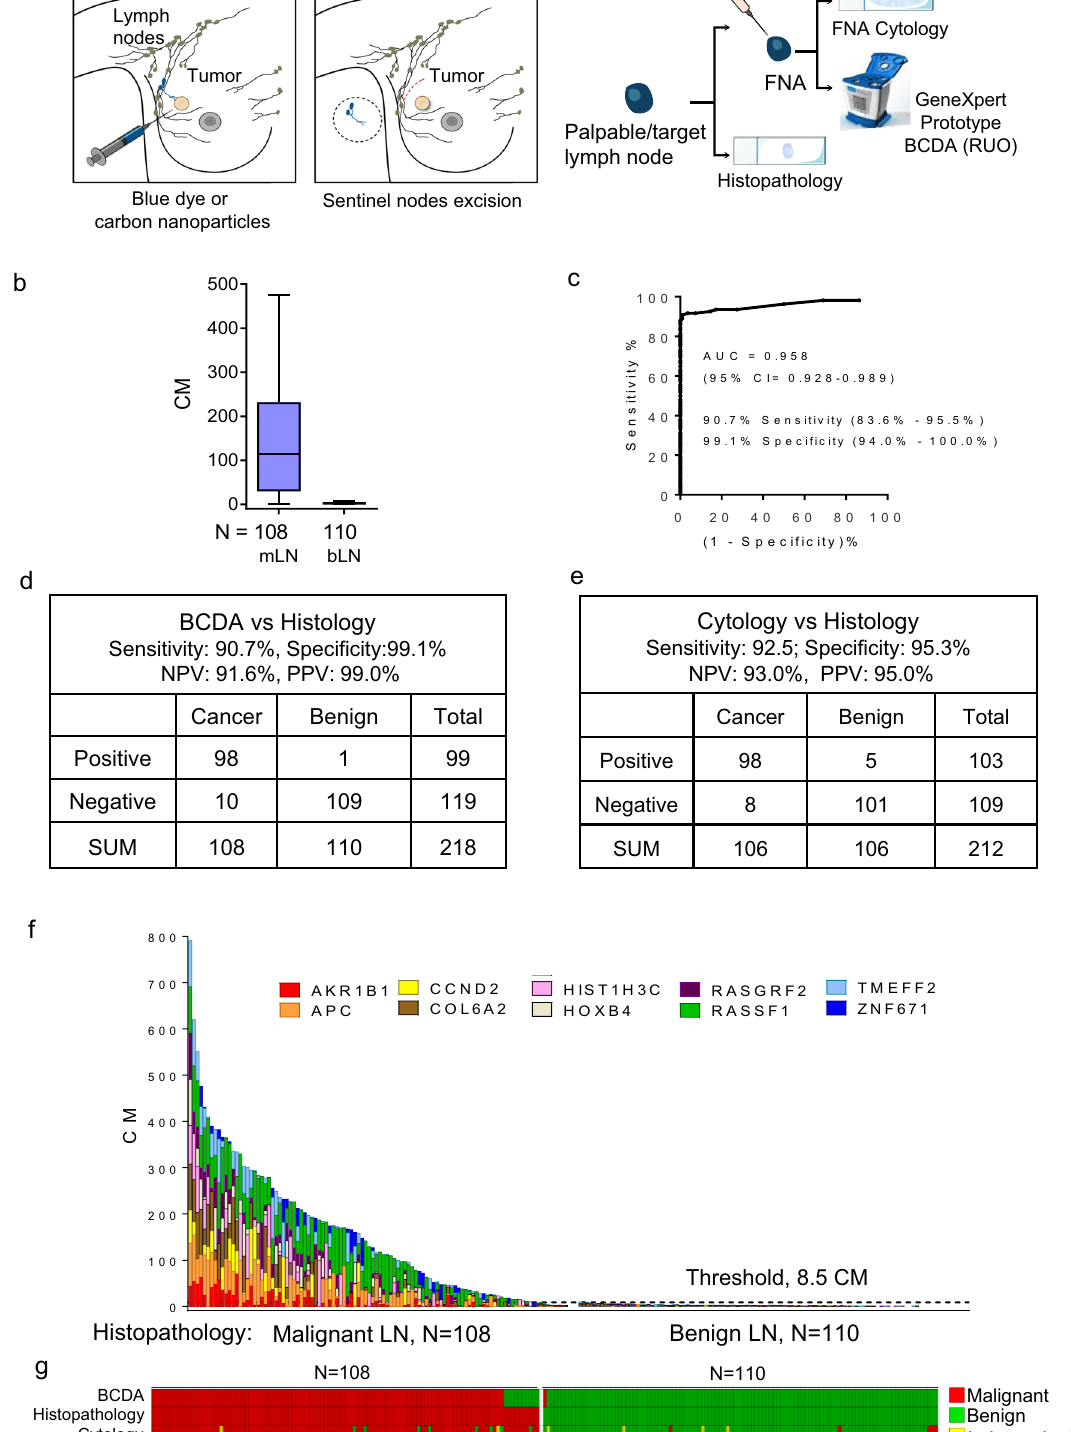
(Supplementary Fig. 1a). Analysis of percent methylation in the samples, assessed for each gene in this sample set, showed a highly signi fi cant difference in methylation levels (Mann – Whitney P values ranging from 0.0001 to 0.0057) between malignant and benign LN-FNAs (Supplementary Fig. 1b).